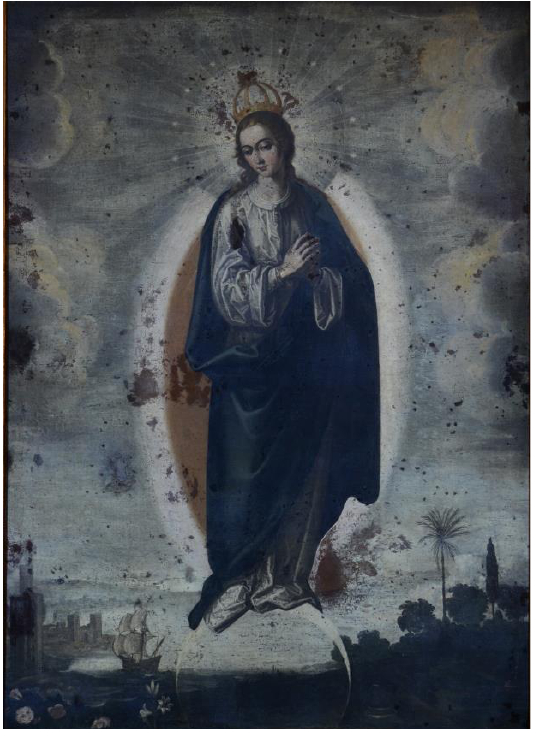
Figure 3. UVF image of La Inmaculada, showing many retouched areas, the largest one located next to the Virgin’s left foot.